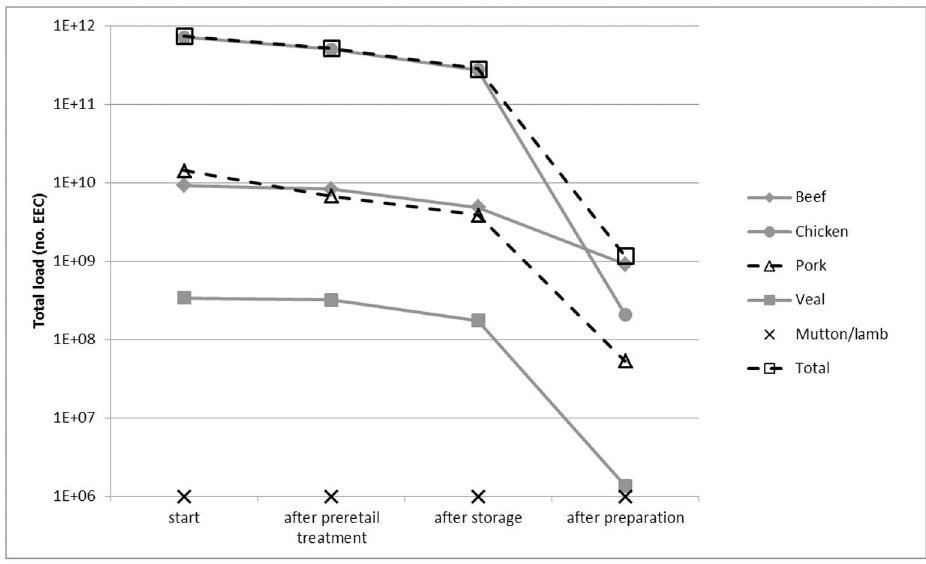
Fig 2. Food animal—specific EEC load. Shown is the load at the start (before any treatment), at retail (after possiblepreretailtreatment), after storage at the consumer and after preparation at the consumer (= at the moment of consumption). The loads refer to the total meat consumptionby the wholeDutch populationin a year. All Mutton/lamb values (marker X) are zero and inserted arbitrarily at the Y-axis 1E+06 value.